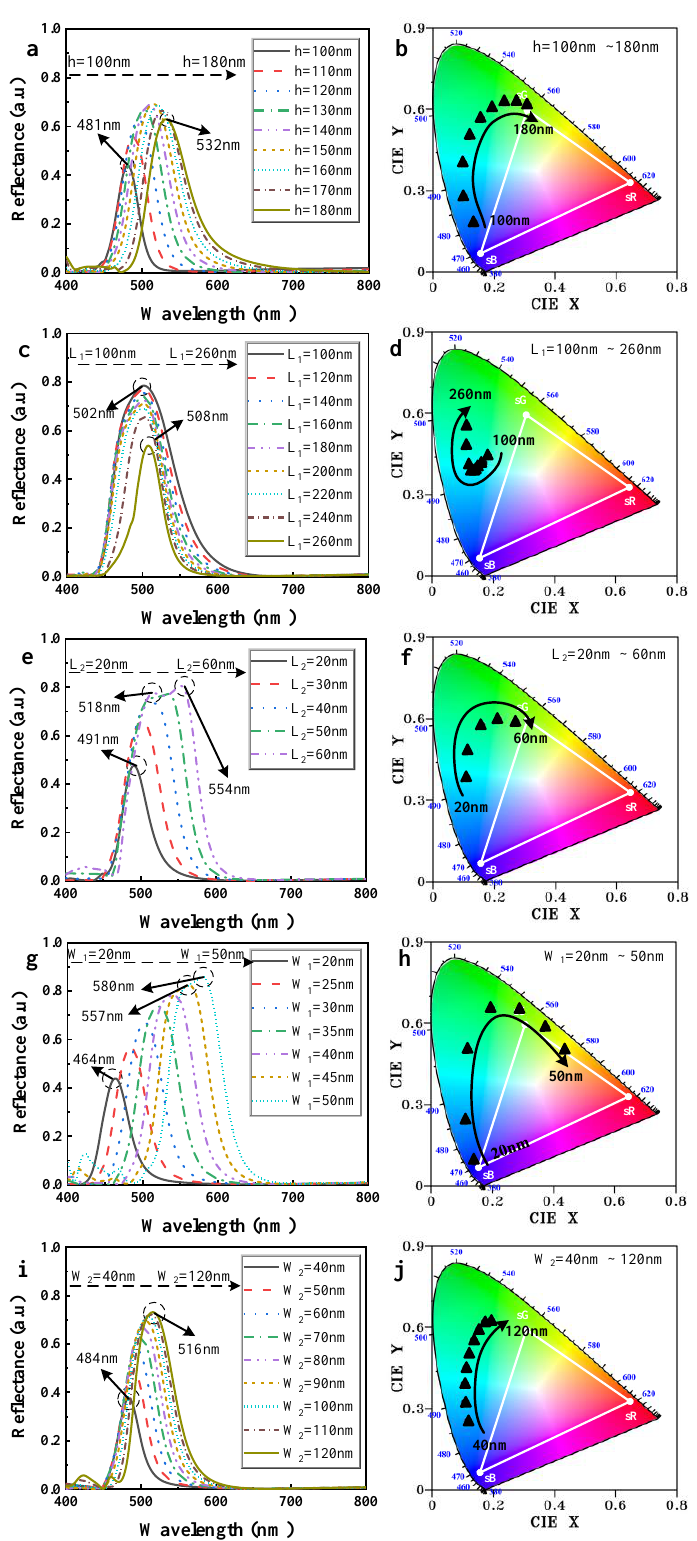
Figure 3. The simulated reflectance spectrum under different conditions: ( a ) h , ( c ) L 1 , ( e ) L 2 , ( g ) W 1 , ( i ) W 2 , and these CIE1931 chromaticity diagrams, corresponding to ( b ) h = 100 ~ 180 nm, ( d ) L 1 =